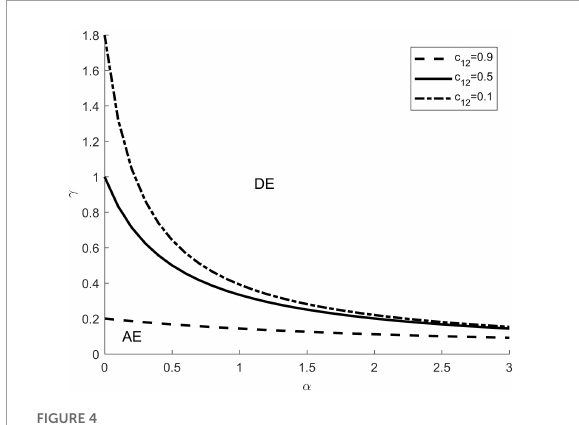
FIGURE4 Analytical relationships for combinations of interspecific competition, vector preference and transmission ratio. The dotted and solid lines represent parameter sets ( α , γ ) for which R 0 = R 1 0 under different competition intensity c 12 . These lines divided α − − γ parameter space into disjoint regions where dilution and amplification effects were exhibited. The upper right of each line represents parameter pairs for which a dilution effect occurs (symbol DE), whereas the lower left of each line represents parameter pairs for which an amplification effect occurs (symbol AE). The other parameters are: K 1 = K 2 = 1000, c 21 = 0 .